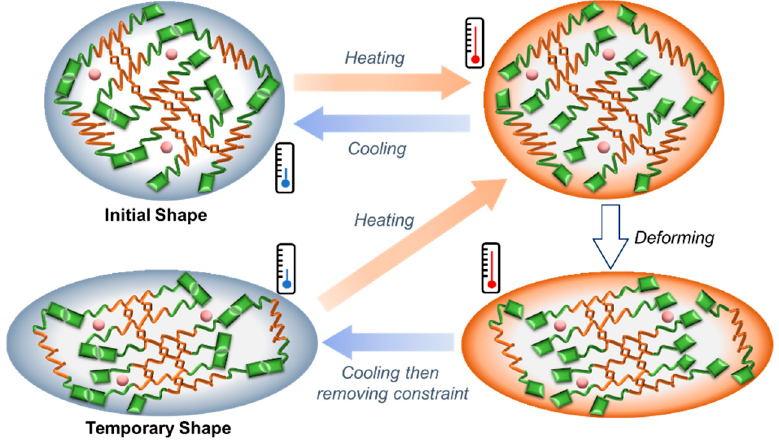
Figure 6. Shape memory mechanism of C-UPy-HTPB-UPy.